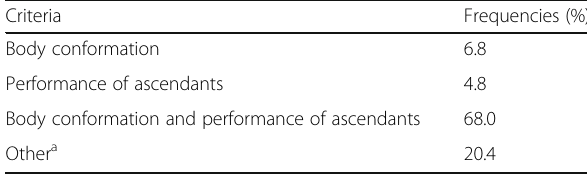
Table 4 Selection criteria for breeding males Criteria